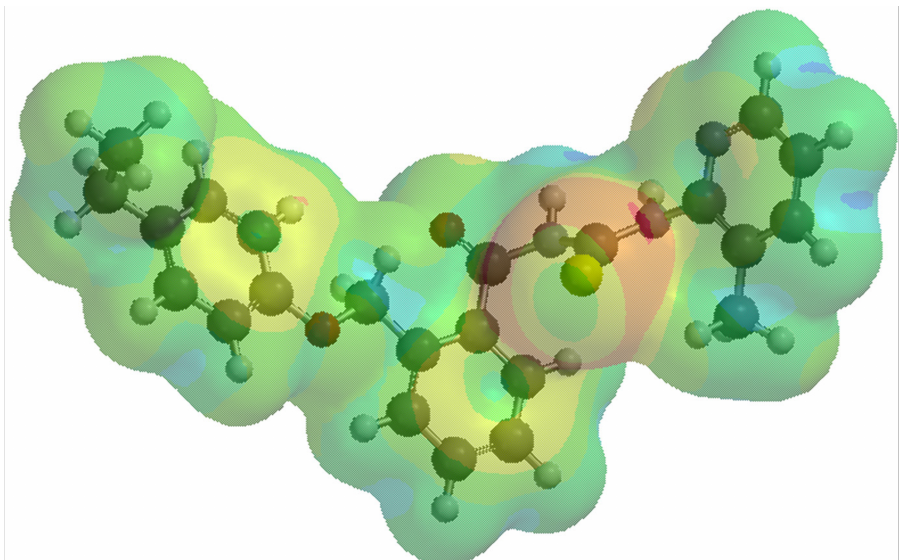
Figure 6. Local ionization potential map for the compound 1d . A red color or shades of red indicate areas where the ionization (the removal of an electron) is relatively easy; the effect is correlated with vulnerability to electrophilic attack. The regions in blue indicate the areas where the ionization is tough. In other words, red regions indicate a low ionization potential, while blue regions mark a high ionization potential. Supporting information with respect to the local ionization potential map representation for every chemical compound enclosed in the current study is provided in the Supplementary Materials, Figure